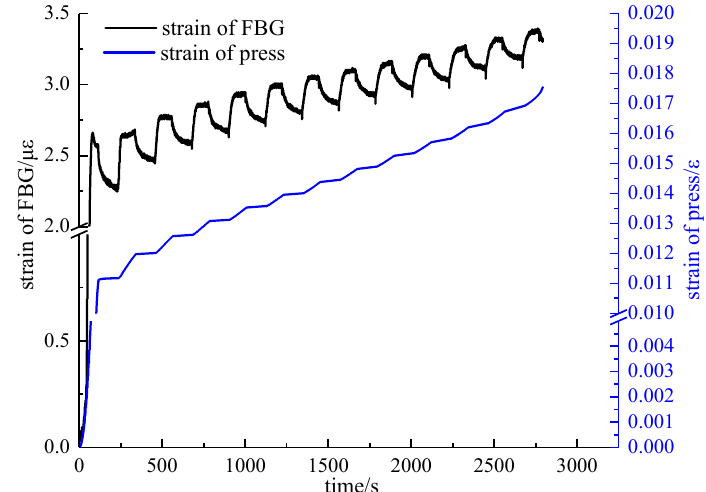
Figure 8. Time-strain curves of the fiber Bragg grating sensor and the press.